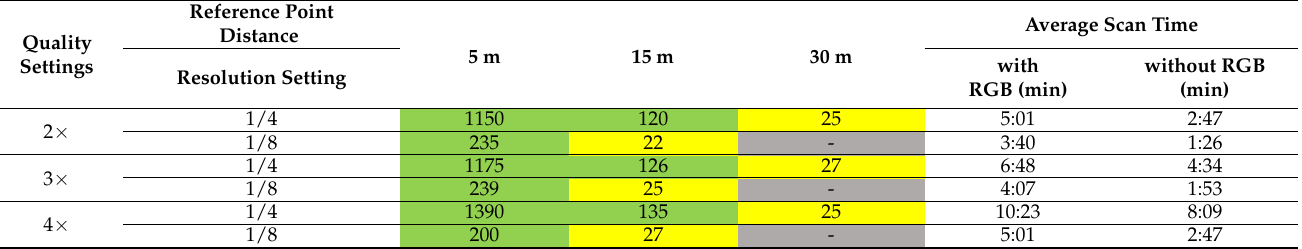
Table 2. Comparison of quality and resolution parameters and average scan